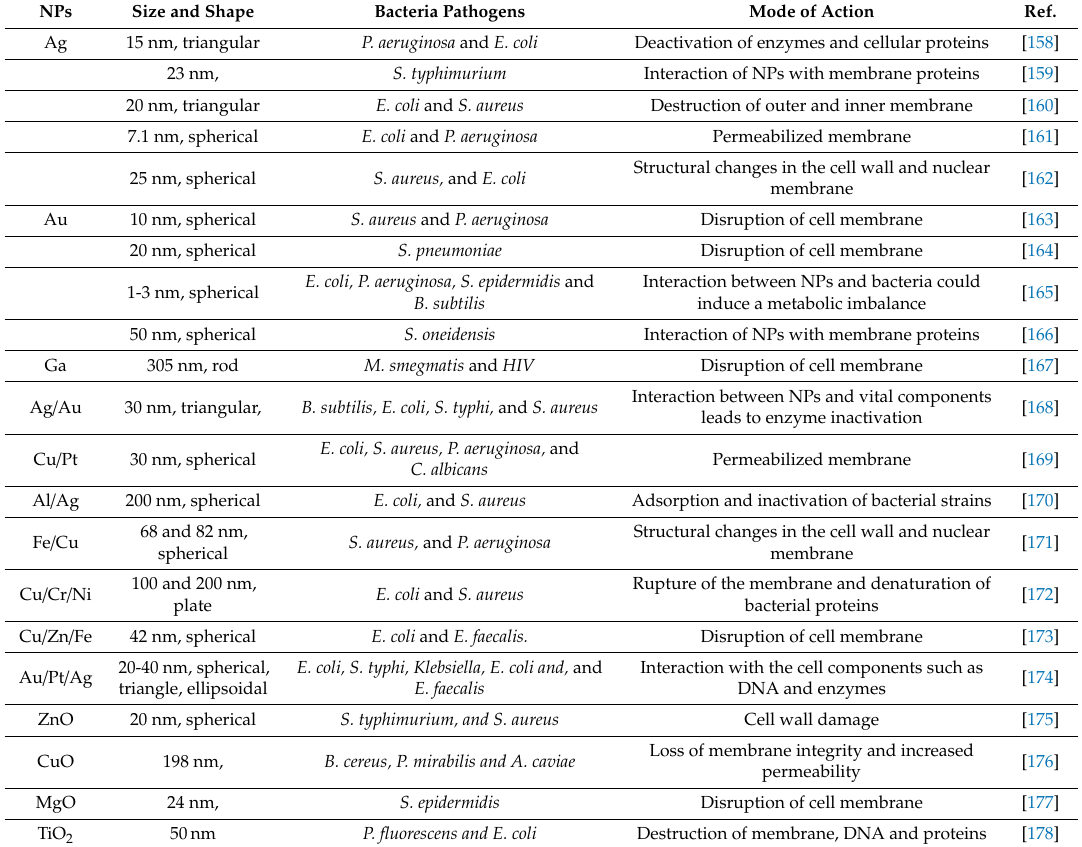
Table 3. Antimicrobial activity of mono, bi-, and tri-metallic and metal oxide nanoparticles, specifically highlighting size, shape, bacterial strains tested, and mode of action NPs Size and Shape Bacteria Pathogens Mode of Action